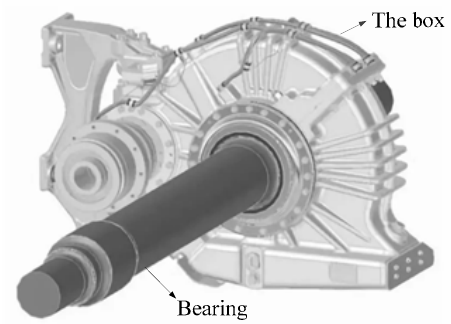
Figure 5. The gearbox of the EMU system.